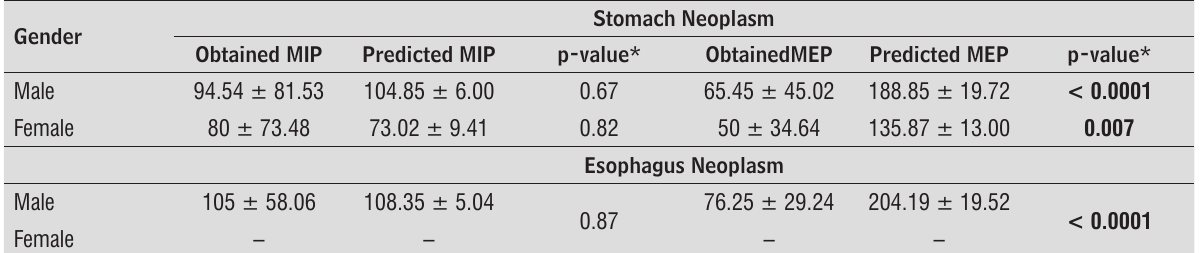
Table 2 - Comparison of maximal respiratory pressures found and predicted of patients with stomach and esophagus neo- plasms according to gender